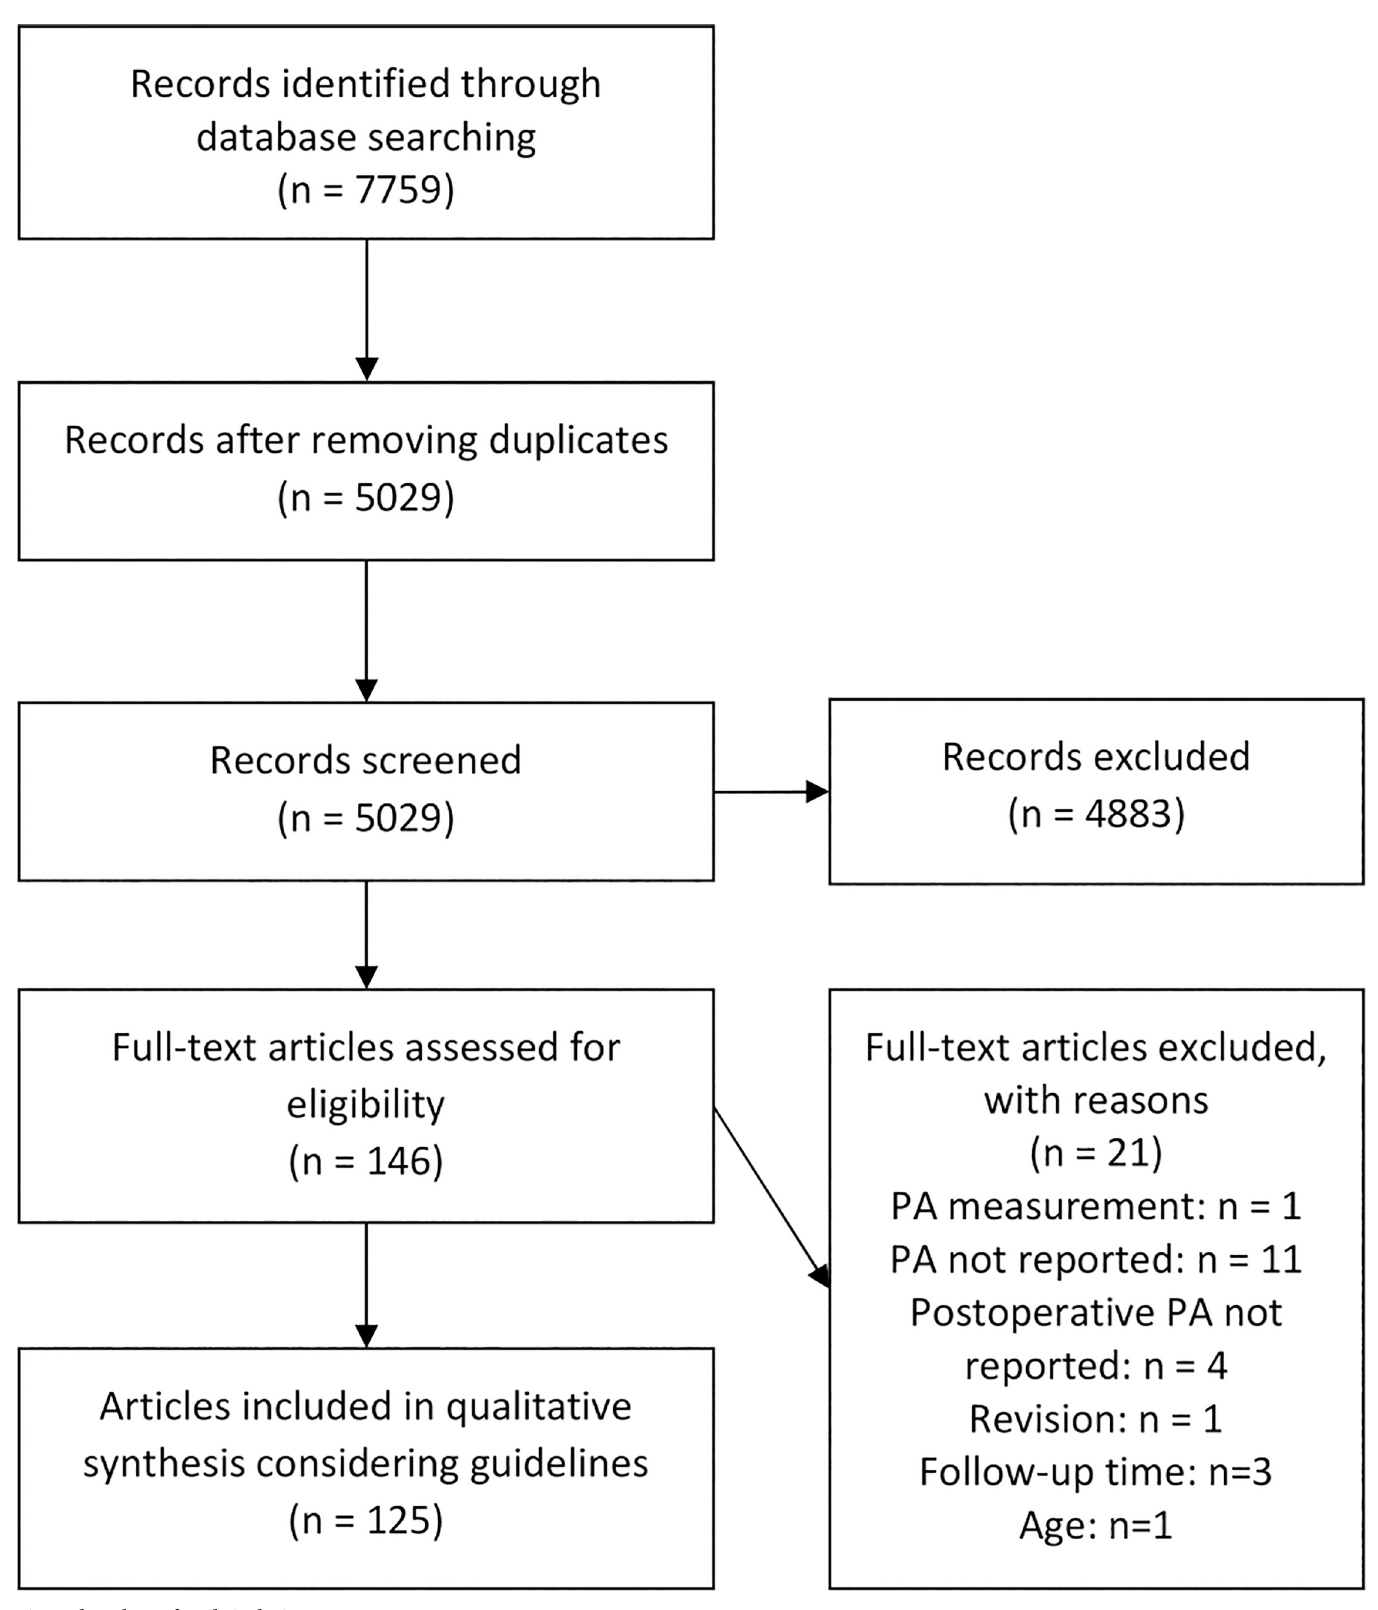
Fig 1. Flow chart of study inclusion. https://doi.org/10.1371/journal.pone.0261784.g001 PLOS ONE | https://doi.org/10.1371/journal.pone.0261784 December28,